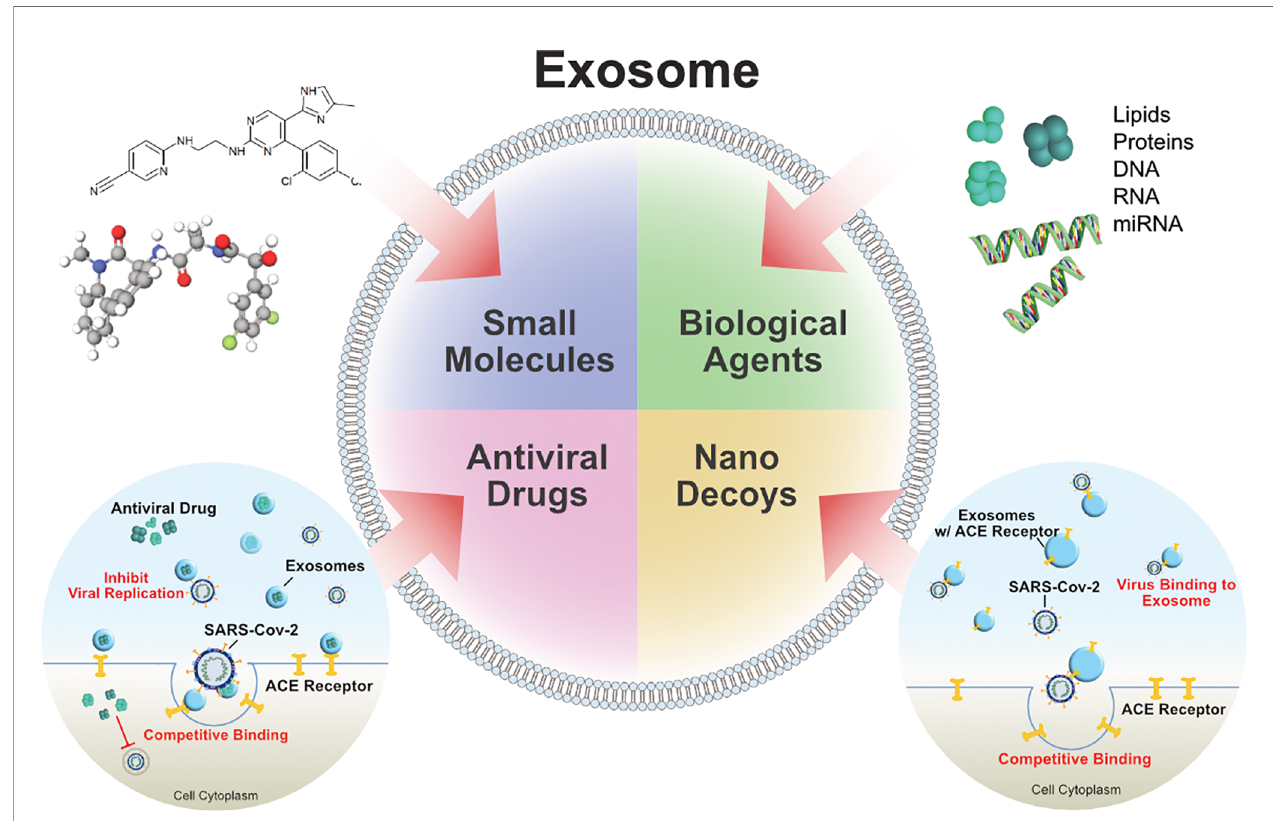
FIGURE 5 | Exosomes as drug carrier for